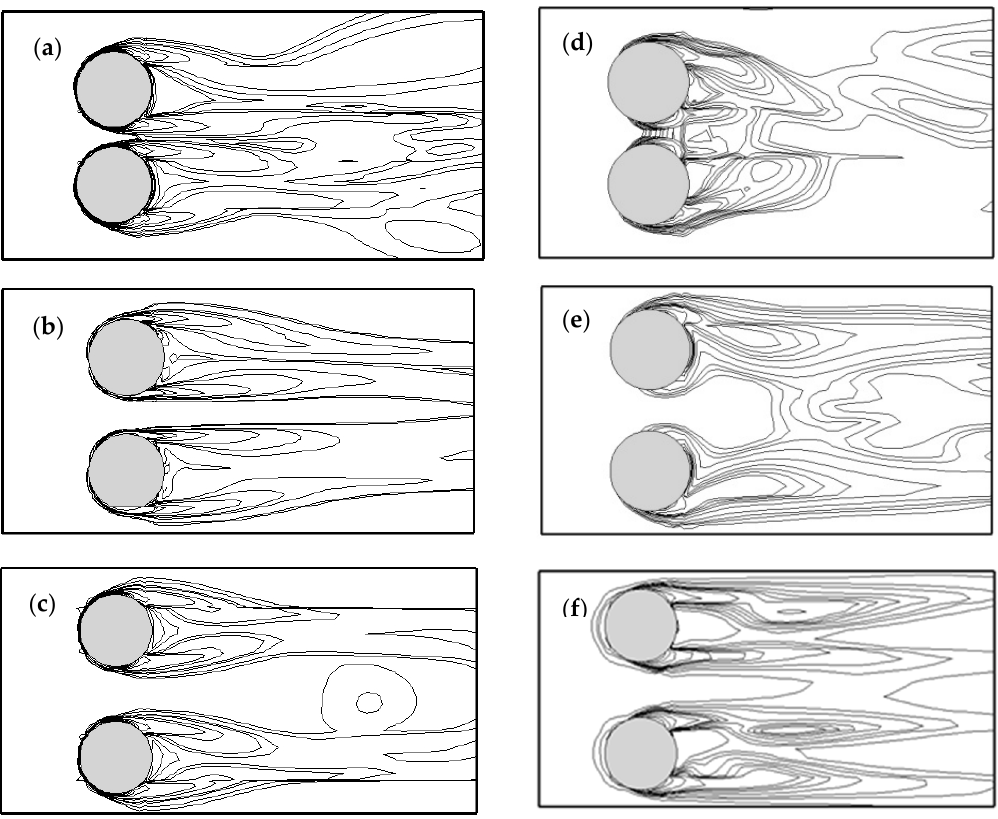
Figure 11. Vortex shedding at G/D = 8.0 is not affected by the walls for the gap ratios: ( a ) T / D = 1.25; ( b ) T / D = 1.5; and ( c ) T / D = 1.75. Vortex shedding is affected at G/D =1.0 for the gap ratios: ( d ), T / D = 1.25; ( e ) T / D = 1.5; (f) T / D = 1.75.